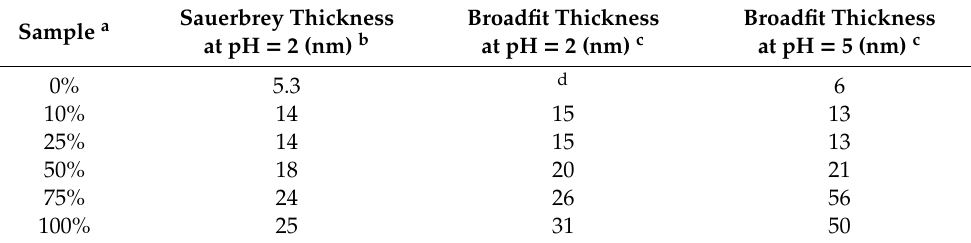
Table 2. Estimated thickness of hybrid films.